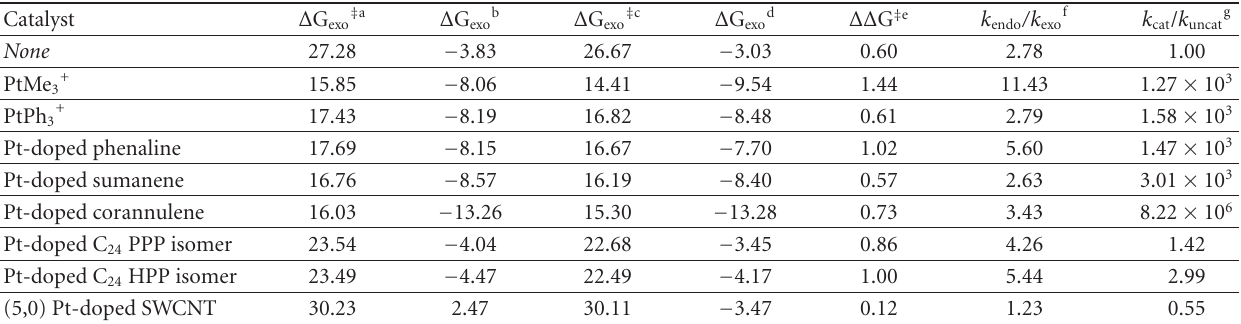
Table 8: Free energies and rates of the Diels-Alder reaction of maleic anhydride and cyclopentadiene as catalyzed by alkyl- and arylplatinum complexes [45]. Catalyst Δ G exo ‡ a Δ G exob None 27.28 PtMe 3+